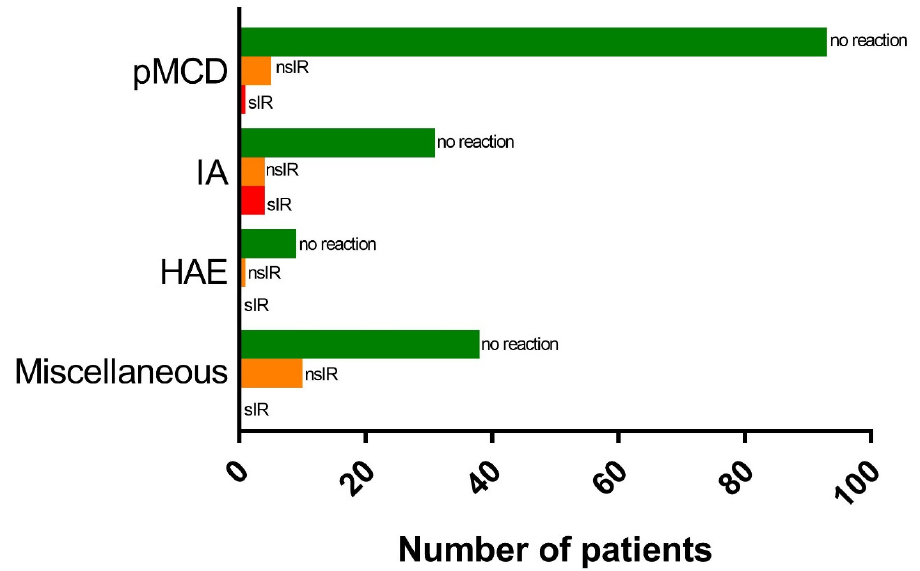
Figure 2. Distribution of immediate reactions among different subgroups. Abbreviations: nsIR, non-severe immediate reaction; sIR, severe immediate reaction; pMCD, primary mast cell disease; IA, idiopathic anaphylaxis; HAE, hereditary angioedema.